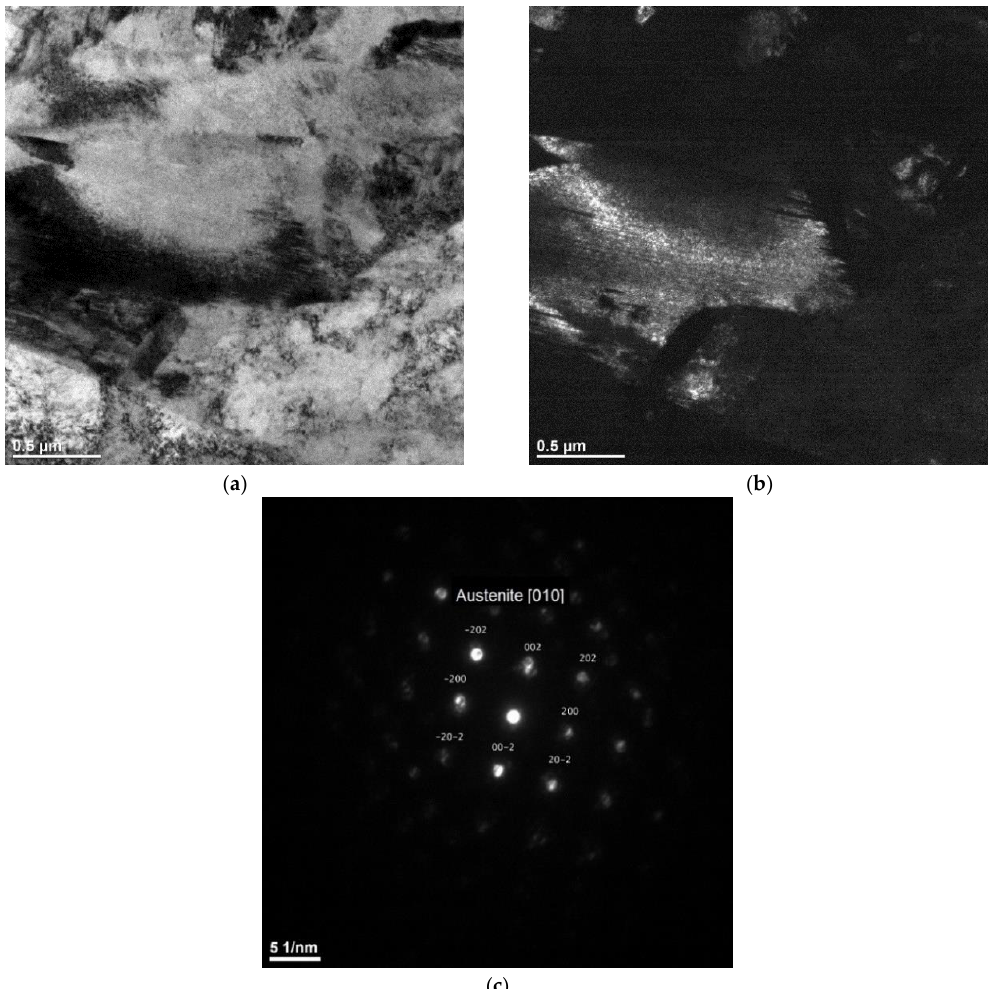
Figure 5. Blocky grain of partially untransformed retained austenite in the specimen deformed at 200 °C: bright field (BF)—( a ), dark field (DF) of RA ( b ), selected area diffraction pattern of RA ( c ).